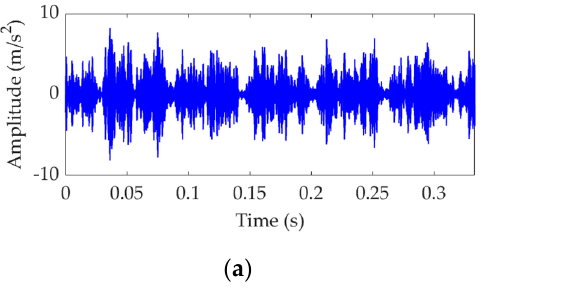
Figure 22. Vibration dataset associated with the ball fault: ( a ) time − domain waveform and ( b ) SES.